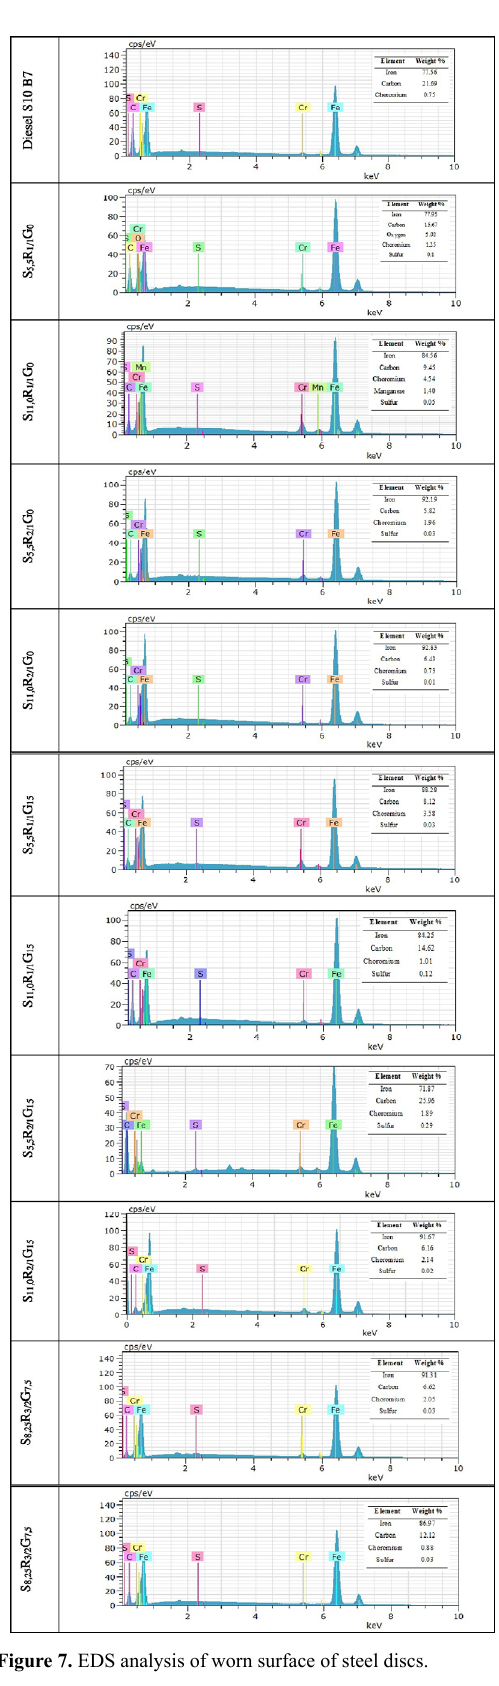
Figure 7. EDS analysis of worn surface of steel